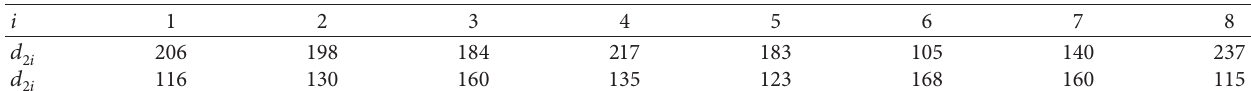
Table 2: The demand of products.